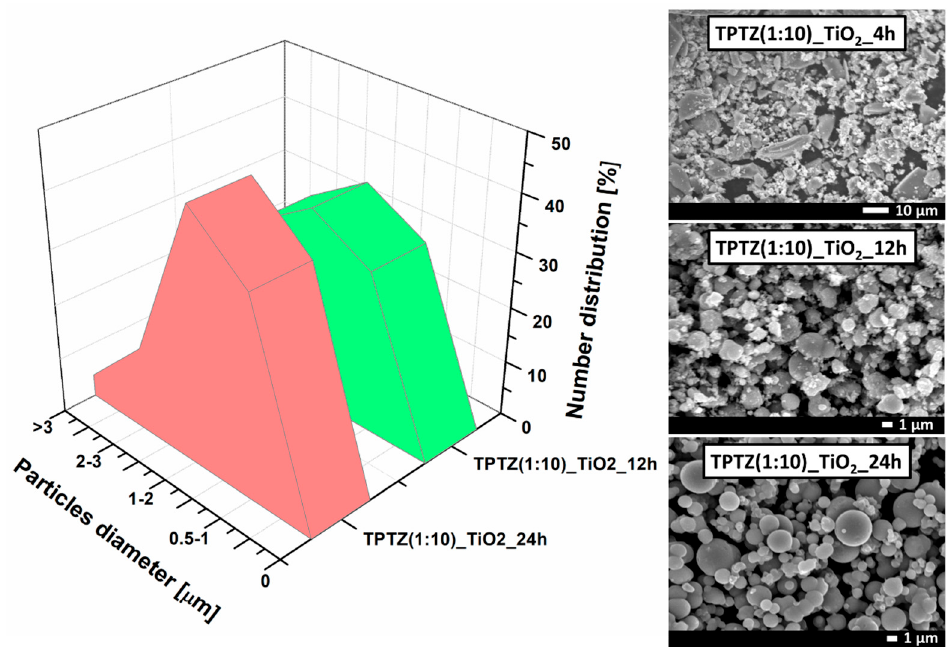
Figure 5. SEM images and particle size distribution of TiO 2 obtained by the solvothermal method in the presence of [TPTZ][Cl] ionic liquid after 4, 12 and 24 h.